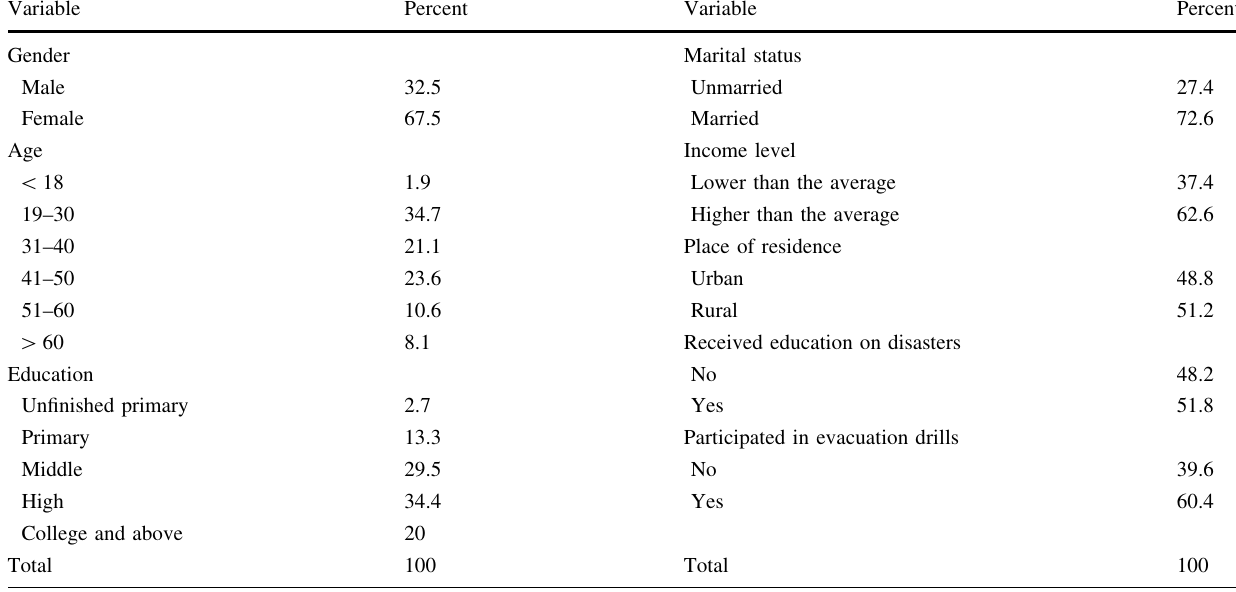
Table 1 Descriptive statistics of the Aba Prefecture and Chengdu City study participants in southwest China Variable